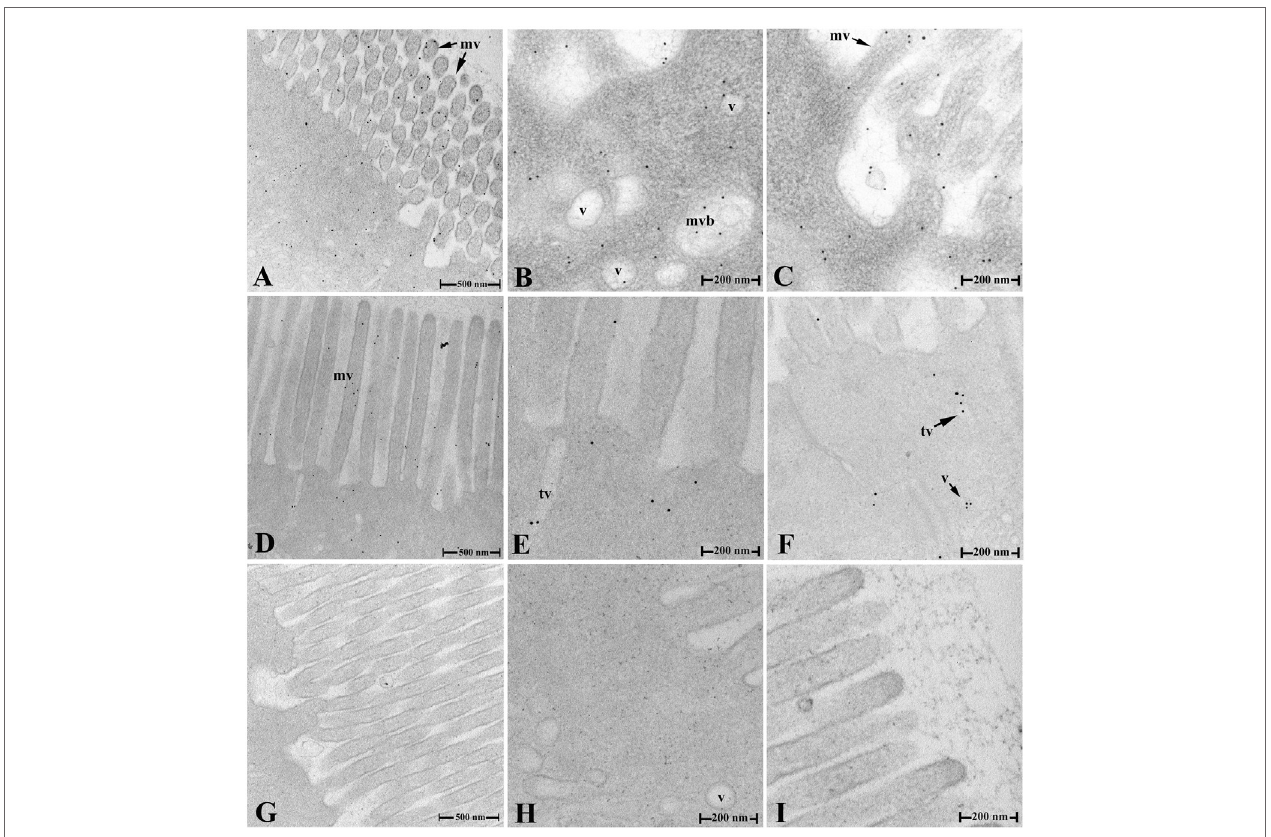
FigUre 4 | Transepithelial transport of the OVA evidenced by IEM. (a–c) The distribution of the OVA-positive gold particles in various sized vesicles, tubules, and multivesicular bodies in the cytoplasm, around the surface microvilli of IECs and in gut lumen in group 1 at 2 h after challenge. (D–F) The distribution of the OVA-positive gold particles in IEC of group 1 at 9 h after challenge. (g–i) No gold particles were detected in negative control staining (g) and IECs of hindgut in group 2 (h,i) at 2 h after challenge. Abbreviations: v, vesicles; tv, tubule vesicles; mvb, multivesicular bodies; mv, microvilli; IECs, intestinal epithelial cells; OVA, ovalbumin; IME, immunogold electron